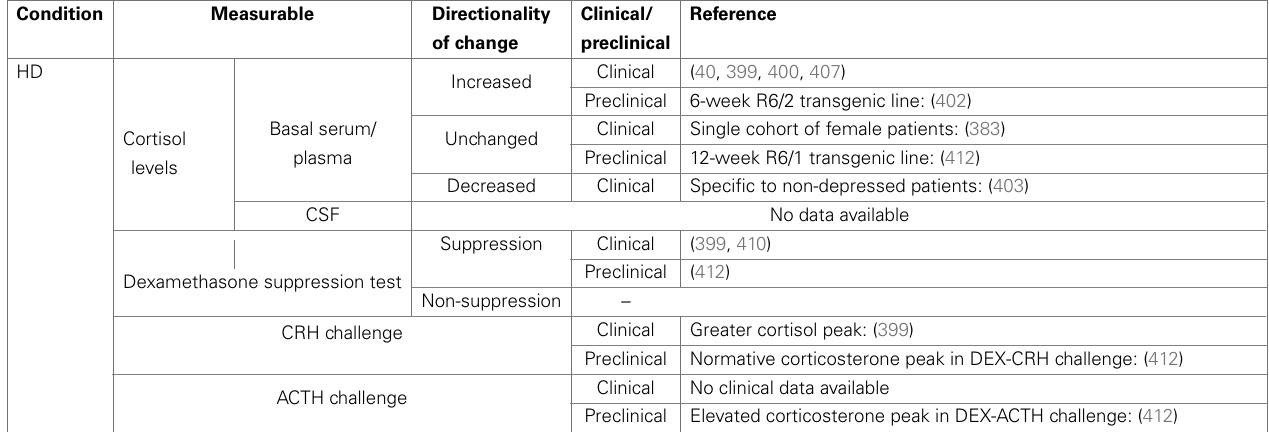
Table 3 | Summary of cortisol changes detected in Huntington’s disease and other functional tests of HPA-axis regulation .